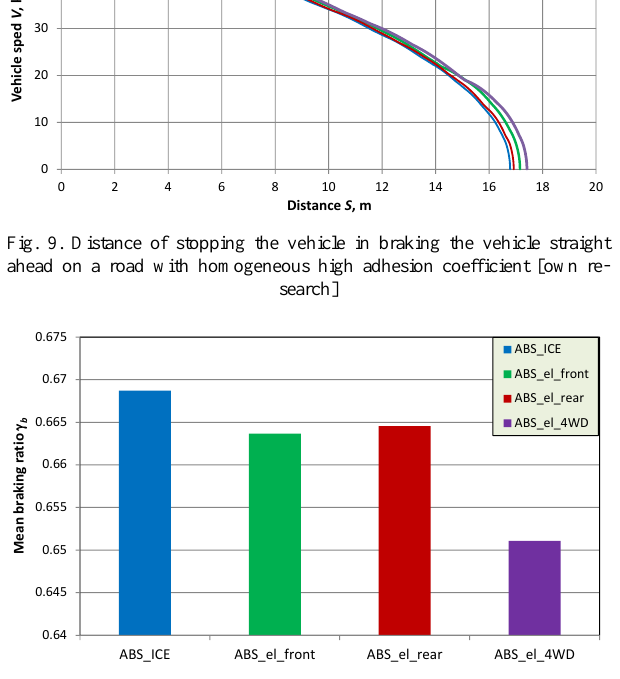
on the road surface with different coefficients of adhesion under the wheels of the right and left side